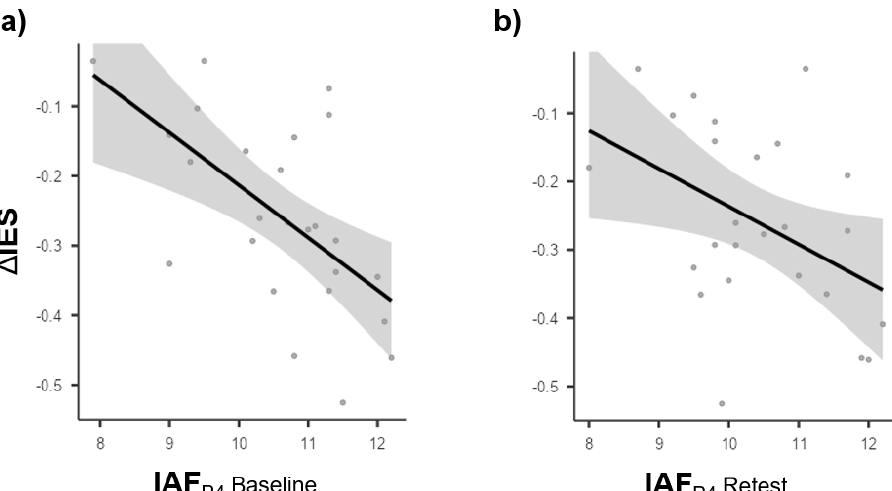
Figure 5. Scatterplots depicting the significant relationships unveiled by the linear regressions between individual alpha peak frequencies over the right parietal lobe and ∆ IES. ( a ) Scatterplot of the relationship between changes in the inverse efficiency scores ( ∆ IES) at retest as compared to baseline ( y -axis) and individual alpha peaks recorded over the right parietal lobe at baseline (IAF P4 baseline; x -axis); ( b ) Scatterplot of the relationship between changes in the inverse efficiency scores ( ∆ IES) at retest as compared to baseline ( y -axis) and individual alpha peaks recorded over the right parietal lobe at retest (IAF P4 retest; x − axis).